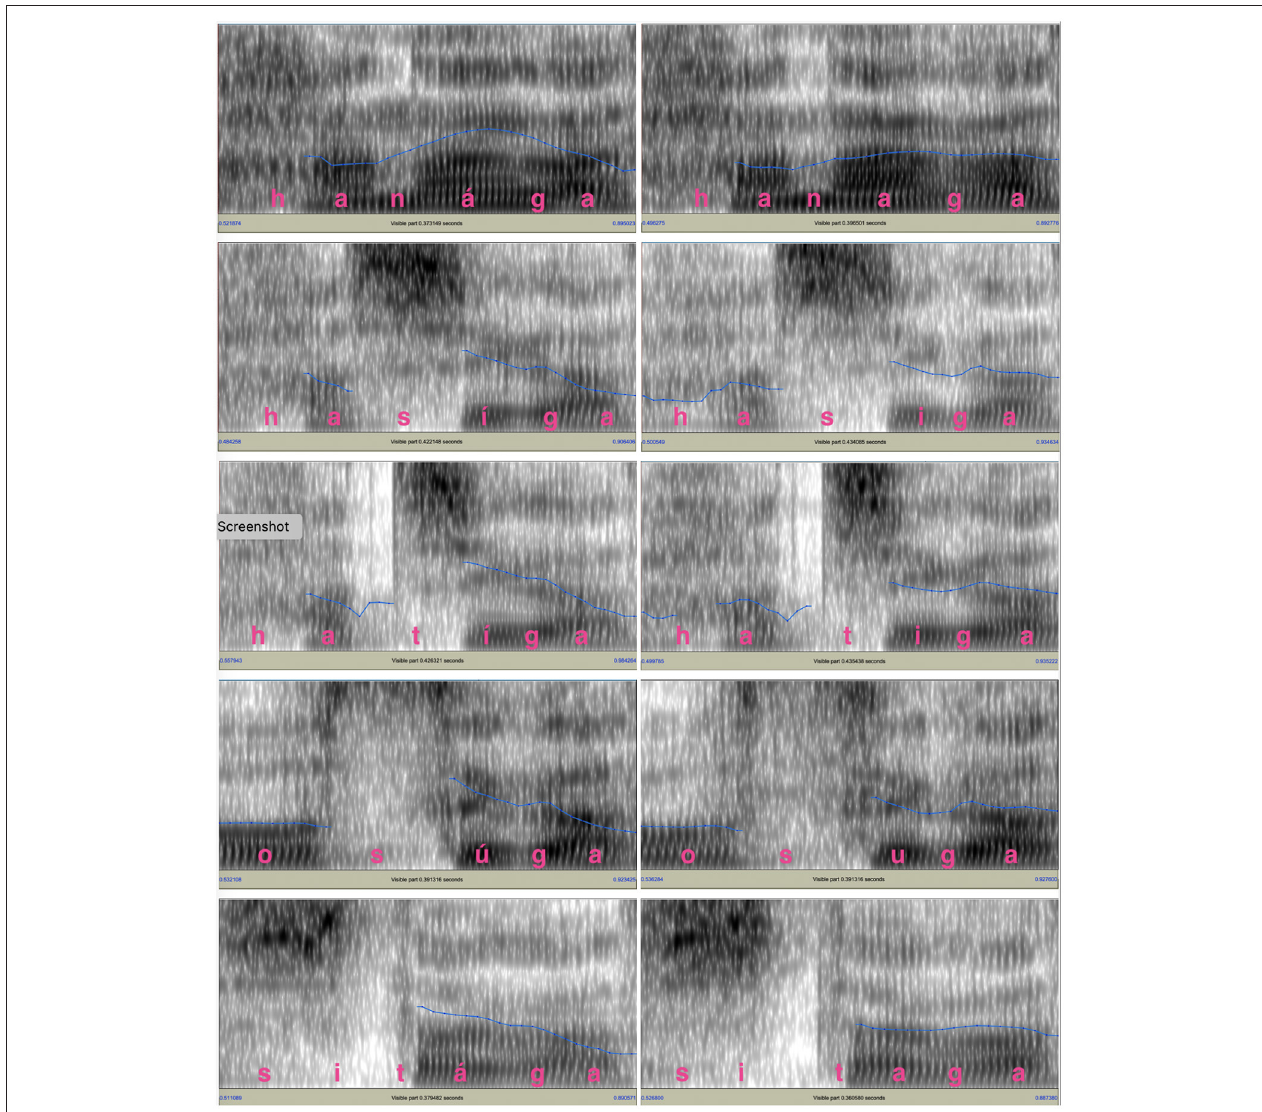
FIGURE 1 | f o contours of the test words and the following particle for the male voice. The blue lines in the spectrograms indicate the f o movements. The f o range is between 75 and 200